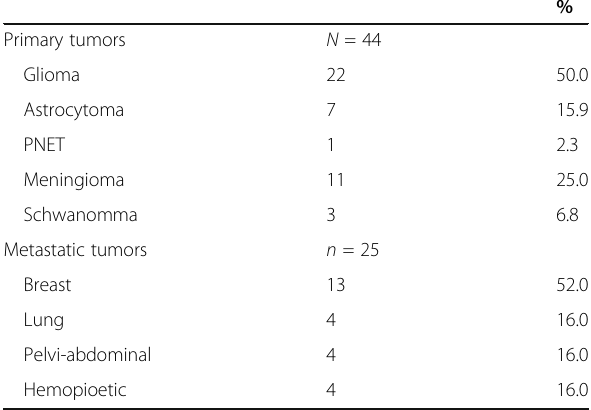
Table 1 variability of tumors included in the study